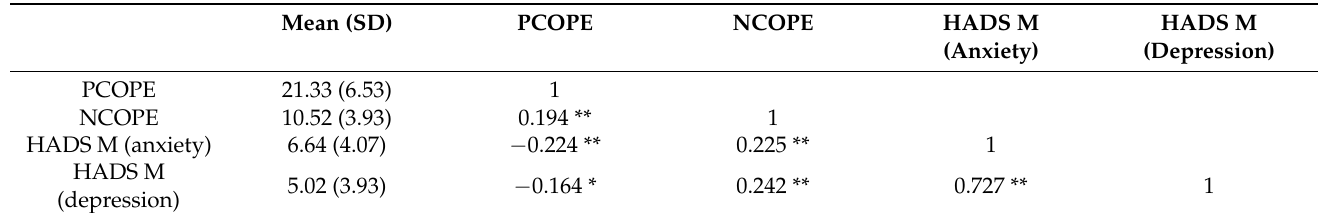
Table 7. Spearman correlation between Brief Religious Coping Scale, anxiety and